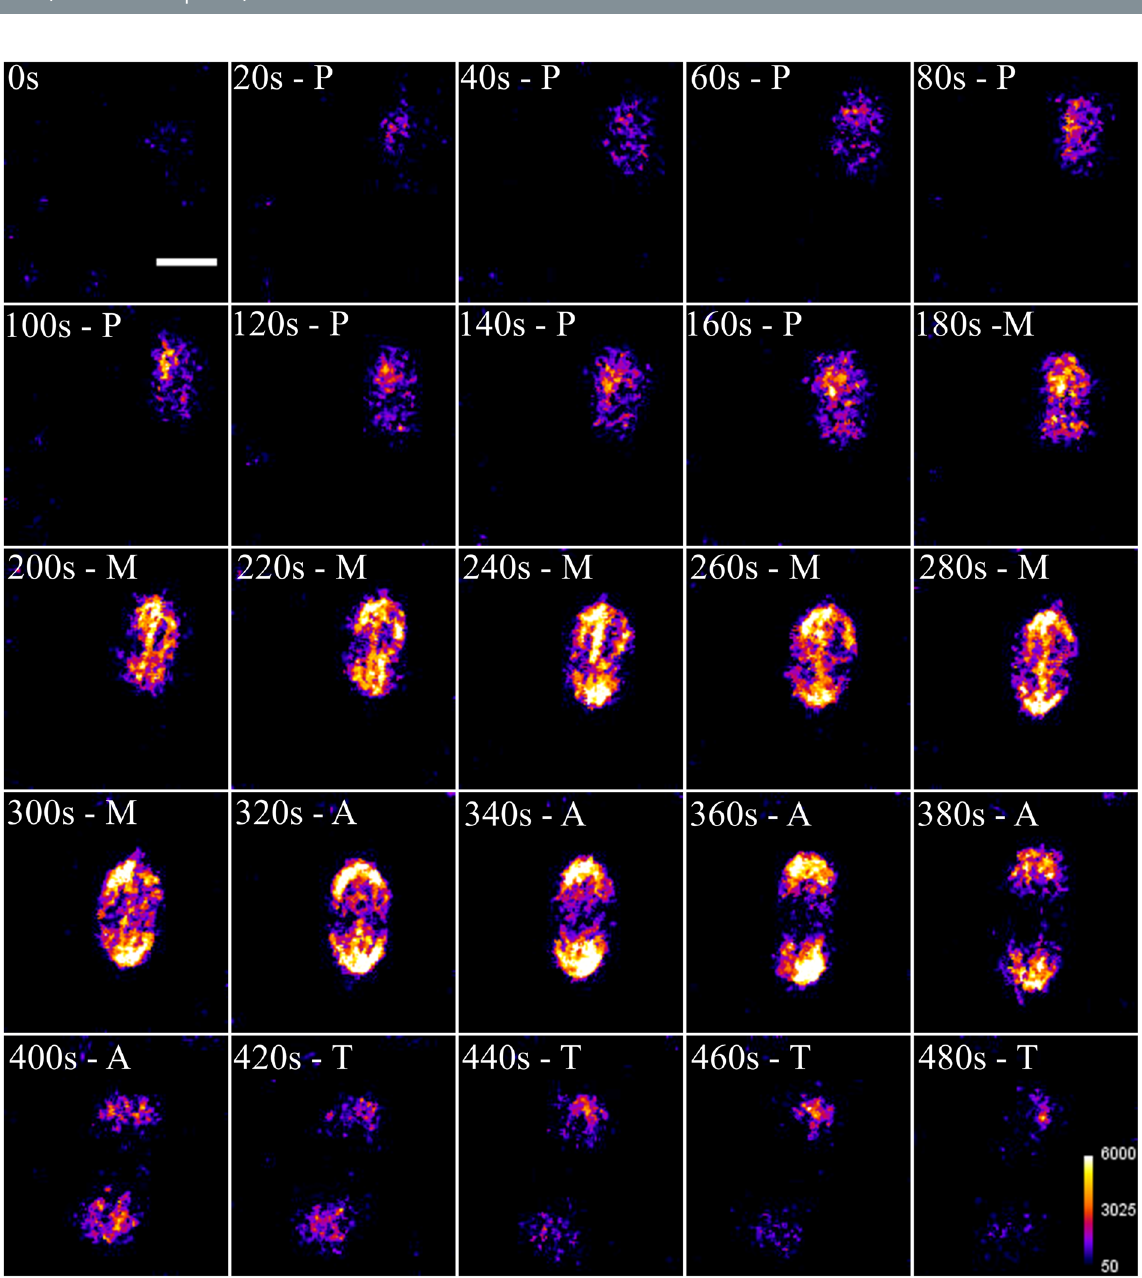
Figure 1. Time-lapse SHG imaging of mitotic spindles during mitotic division of a zebrafish embryo. Prometaphase (P; 20–160 s), metaphase (M; 180–300 s), anaphase (320–400 s) and telophase (420–480 s). Average power at focus: 150 mW, photomultiplier tube set at 1100 V. Scale bar: 10 µ